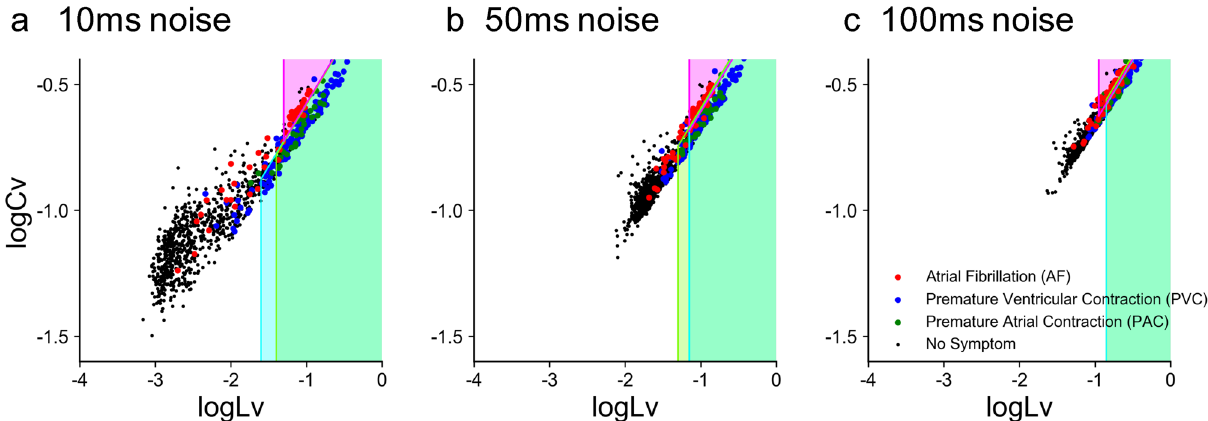
Figure 7. Noisy datasets of different cardiac disorders plotted on a plane spanned by log 10 Lv and log 10 Cv . ( a ), ( b ), and ( c ): Datasets were obtained by jittering original pulse times with Gaussian noises of the standard deviation of 10 ms, 50 ms, and 100 ms. The parameters a and b of each prediction zone were adapted to respective noisy datasets.